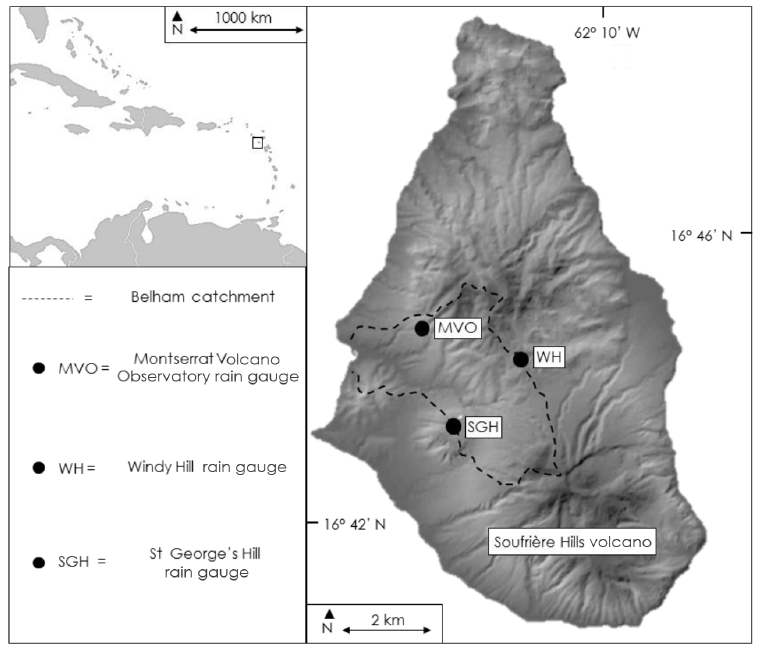
Figure 1. Location map of Montserrat and the Soufrière Hills volcano.